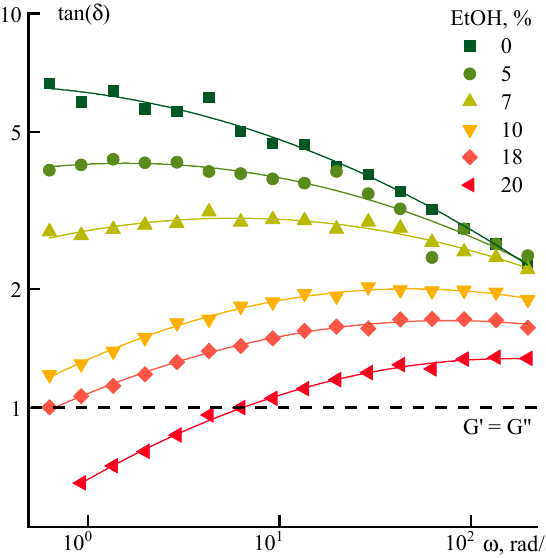
Figure 8. Dependence of the tan( δ ) for PANI-O solutions containing di ff erent amounts of ethanol (indicated on the graph).